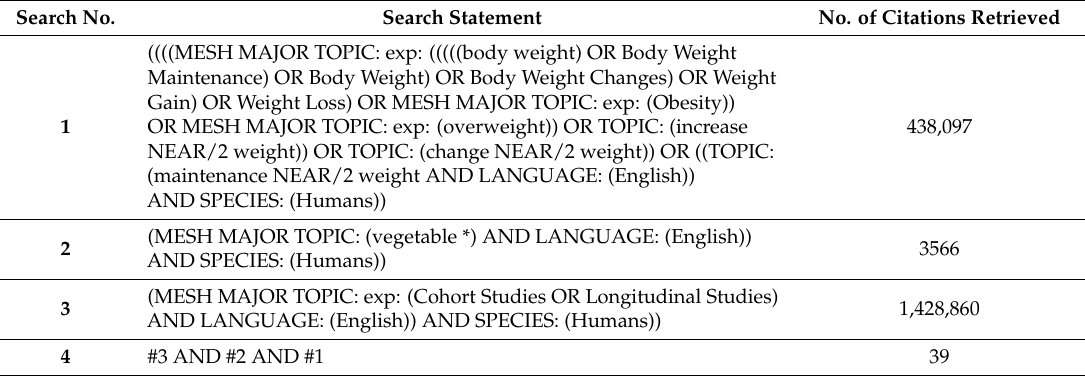
Table 1. Electronic database search strategy: Medline (via Web of Science). Search